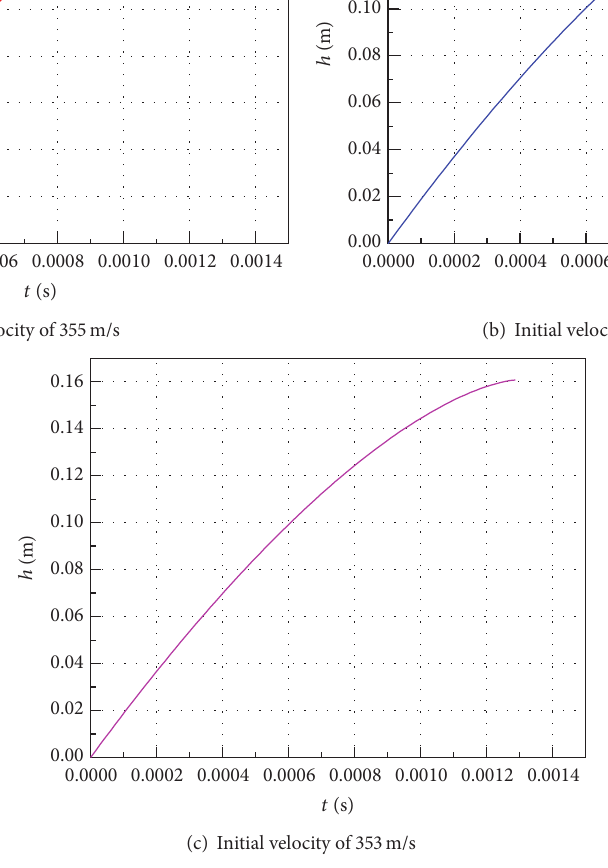
Figure 11: Penetration depth